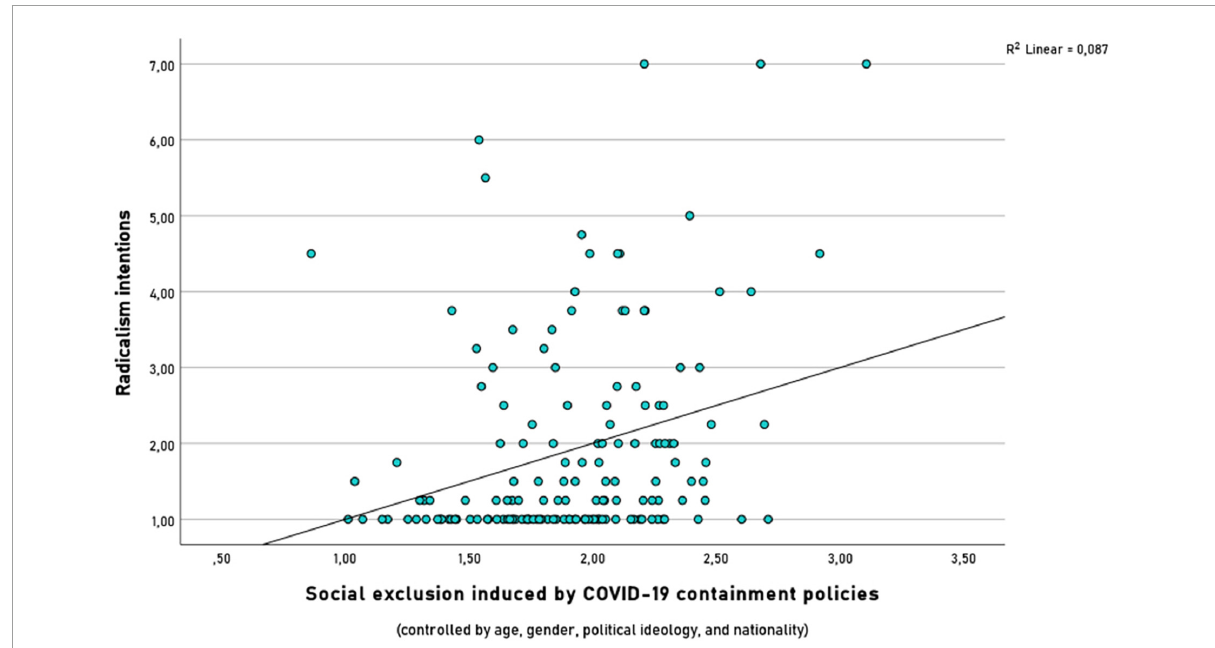
FIGURE1 Results of the regression model: Feelings of social exclusion induced by the COVID-19 containment policies predicted radicalism intentions to illegally and violently fight against those; the regression model controlled for age, gender, political ideology, and